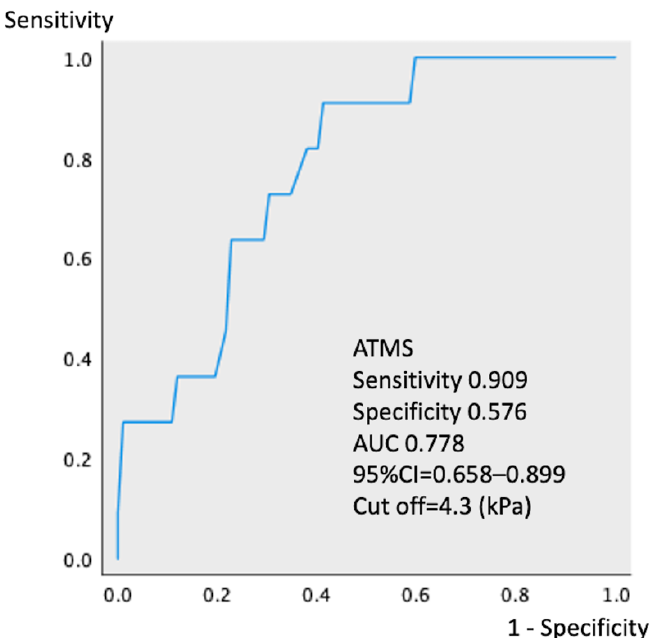
Figure 2. Receiver operating characteristic analysis showing that the cutoff value for abdominal trunk muscle strength is 4.3 kPa (95% confidence interval 0.643 – 0.909, p = 0.004, AUC 0.776). The sensitivity and specificity are 0.909 and 0.576, respectively. ATMS, abdominal trunk muscle strength; AUC, area under the curve; CI, confidence interval.